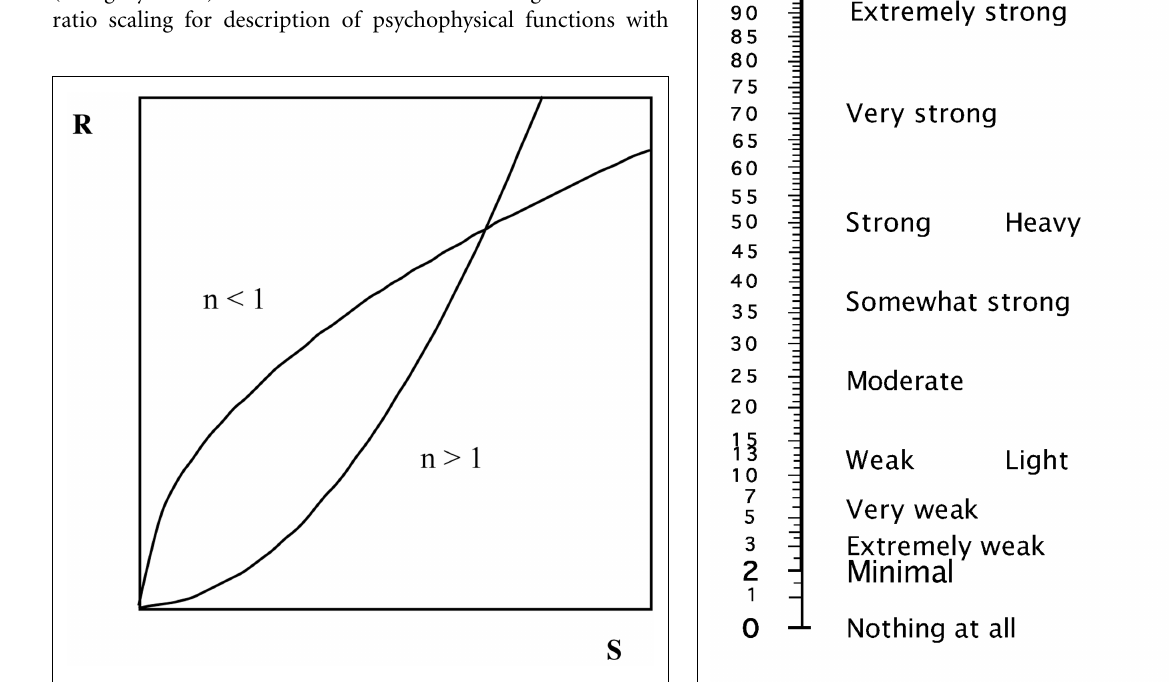
FIGURE 1 |Two theoretical S-R functions obtained with ratio scaling. Examples of exponents above 1 ( n > 1) are perceived exertion (1.6), heaviness (1.45), muscle force (1.7), and electric shock (3.5). Examples of exponents below 1 ( n < 1) are brightness (0.3–0.5), loudness (0.6), and visual area (0.7).